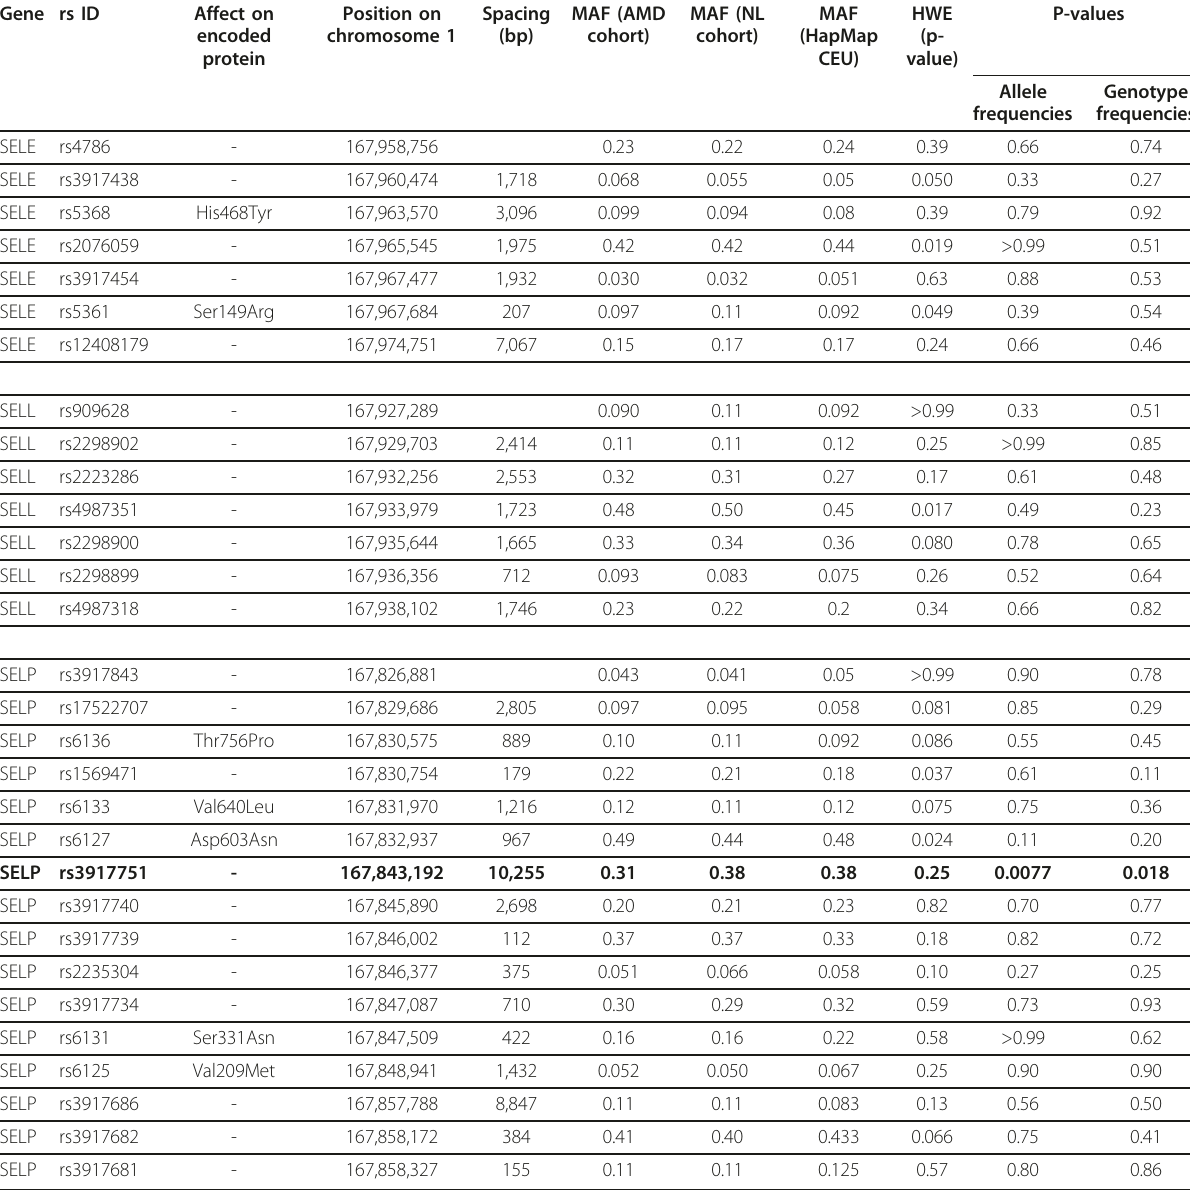
Table 1 SNPs evaluated in SELE , SELL and SELP Gene rs ID Affect on